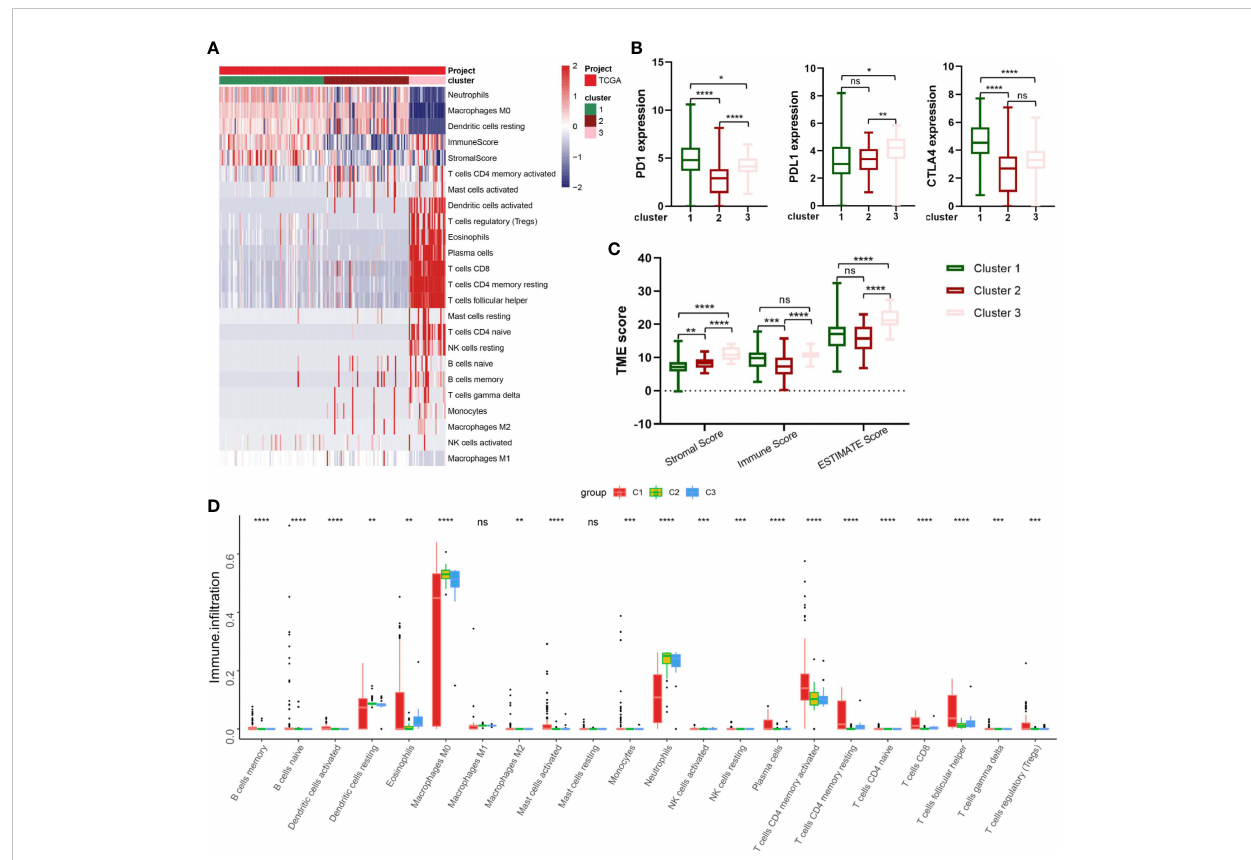
FIGURE 4 Correlation between IRG subgroups and tumor microenvironment in virus-related liver cancer (TCGA cohort). (A) heatmap displaying clustering of tumor-in fi ltrating immune cells in TCGA cohort. Rows represent tumor-in fi ltrating immune cells, and columns represent samples. (B) Expression levels of PD-1, PD-L1, and CTLA-4 in the three virus-related HCC subgroups. (C) Comparison of TME scores among IRG subgroups. (D) Abundance of 23 in fi ltrating immune cell types in the three virus-related HCC subgroups. *p<0.05; **p<0.01; ***p<0.001; ****p<0.0001; ns, not signi fi